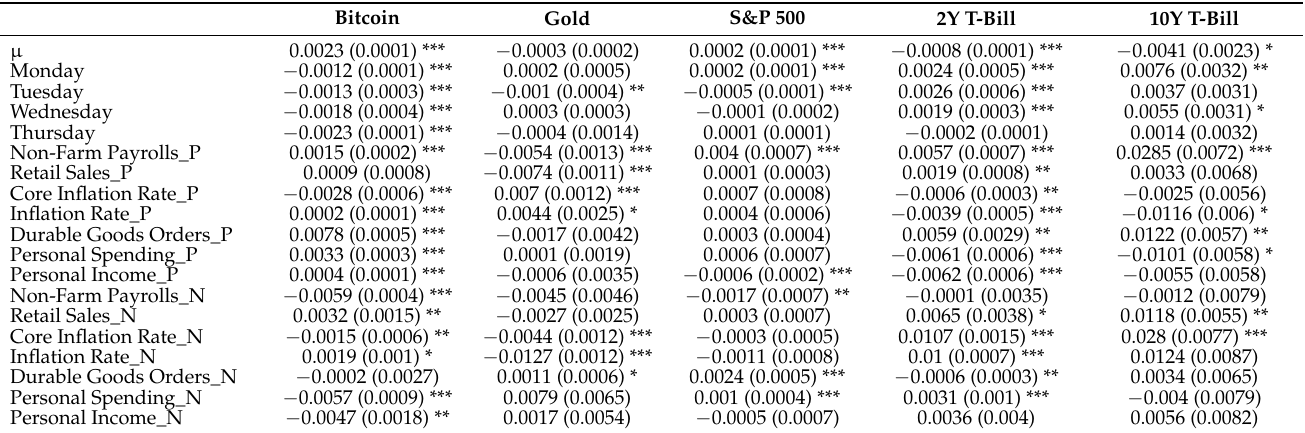
Table 4. Impact of the U.S. announcements on the observed assets’ returns. Bitcoin